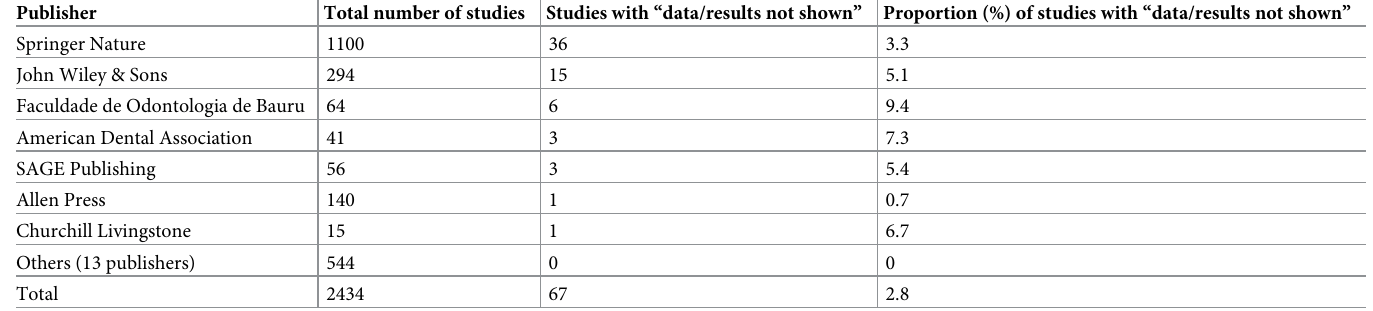
Table 3. The number of available open access articles from Europe PubMed Central and the number of articles with “data/results not shown” phrases in journals of each